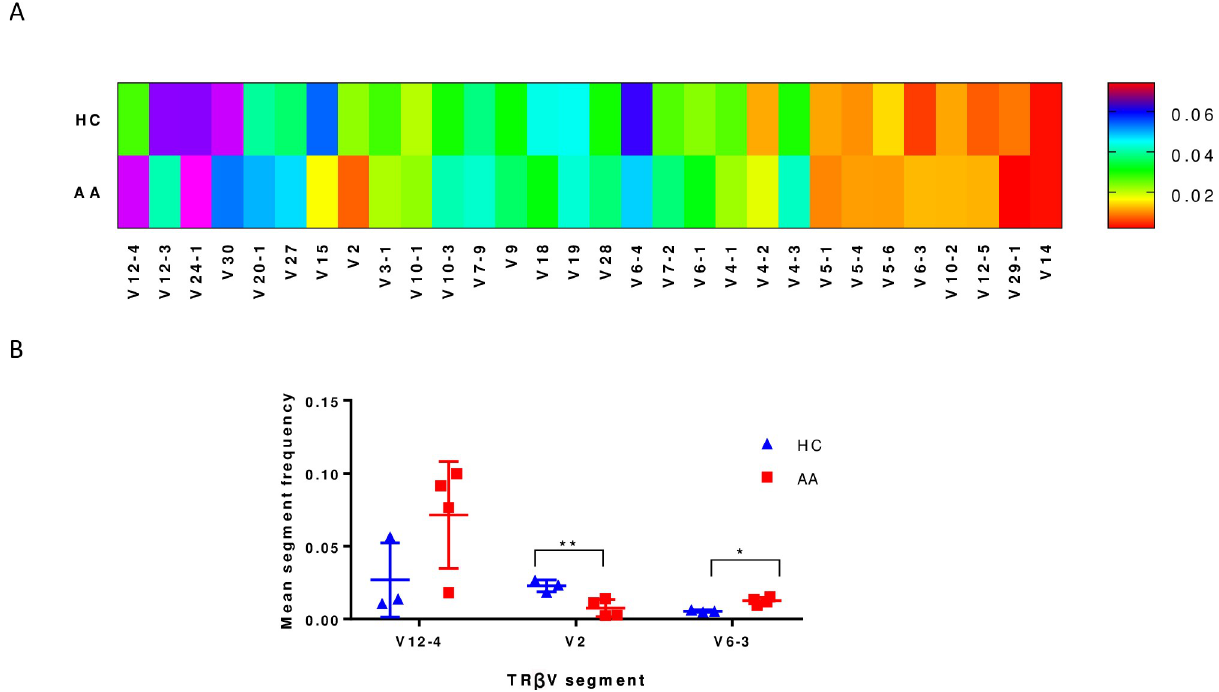
Fig 5. Gene segment usage in TCR of Tregs. A . frequency of each V segment usage in healthy control (HC) and AA cases, the data represented in the heat map is the mean of three HCs and four AA patients B . Statistical analysis of the observed changes in TCR β V segment usage between HC and AA where the difference was calculated by ANOVA and � P < 0.05.